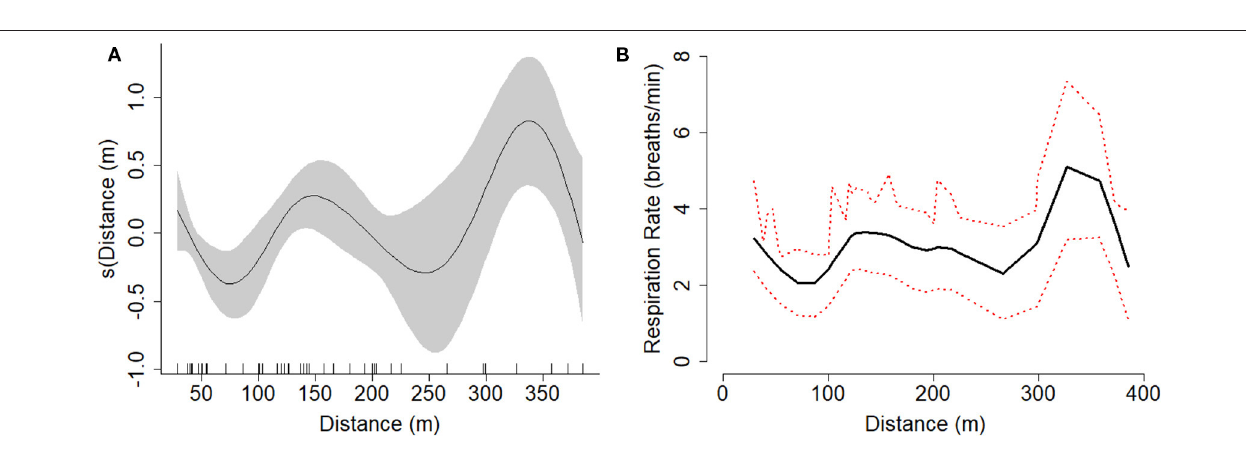
FIGURE 7 | Results from the best fit generalized additive model (GAM) for humpback respiration rate showing (A) model parameter estimates of vessel distance to focal group and (B) model predicted respiration rate based on vessel distance. The shaded and dashed lines represent the 95% confidence intervals of the parameter estimates and fitted values, respectively. The vertical ticks on image (A) indicate the locations of observations (i.e., a